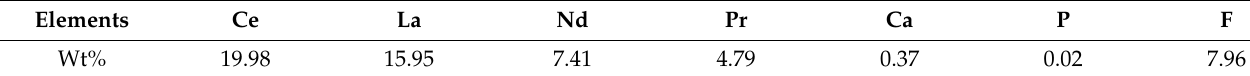
Table 1. Chemical composition of bastnaesite.